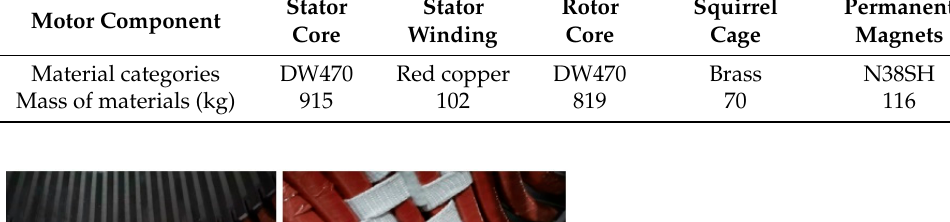
Figure 22. Rotor structure: ( a ) rotor; ( b ) top view of rotor. Table 4. Introduction of HVLSPMSM consumption materials.